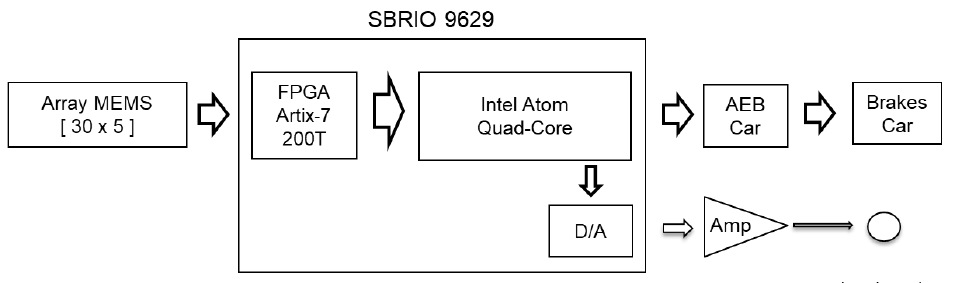
Figure 2. Hardware setup diagram.